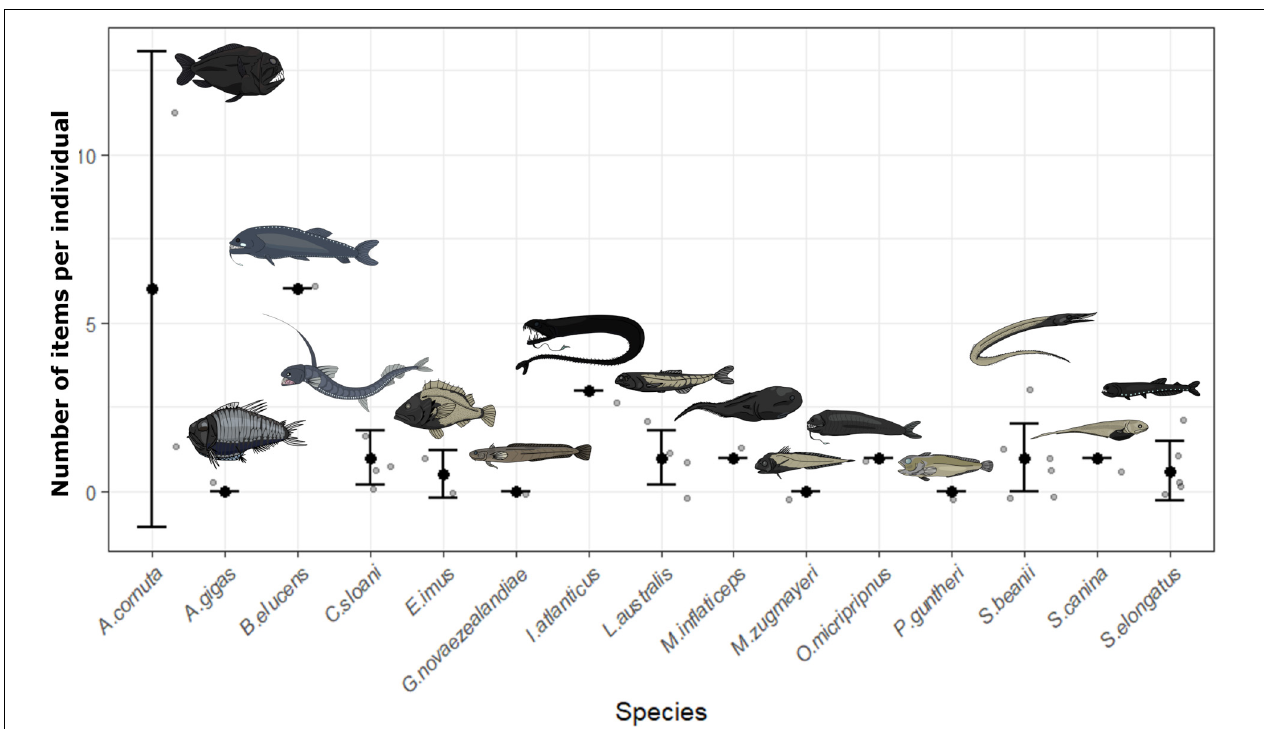
FIGURE 2 | The number of fibers ingested by 13 mesopelagic fish species and two species collected from rockpools and surface waters ( Gaidropsarus novaezealandiae , Patagonotothen guntheri ). Gray points represent data for individual fish whilst black dots are the mean with whiskers of ± one standard